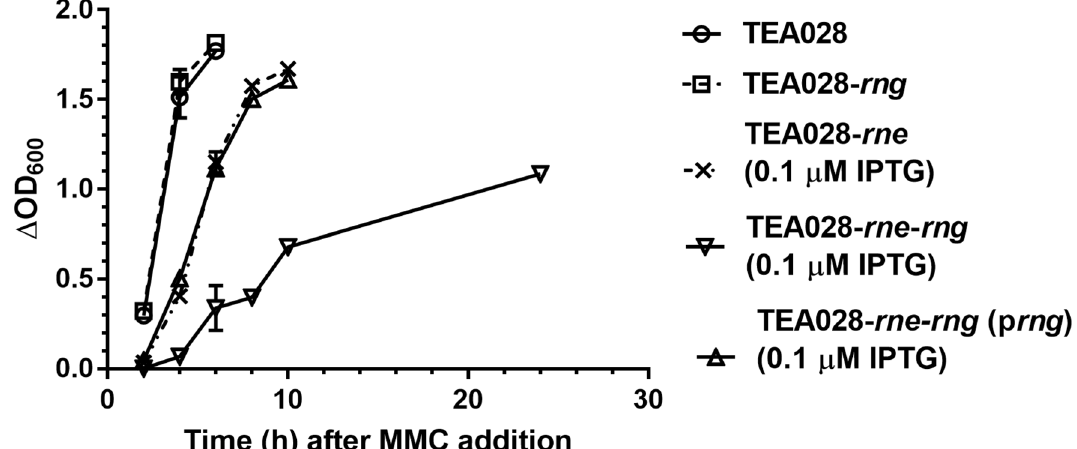
Figure 1. Growth of EHEC TEA028 and its RNases E and G derivative strains in cultures treated or non- treated with mitomycin C (MMC). Cultures of TEA028 (parental strain) and its RNases E and G derivatives were grown in Luria Bertani medium to optical density at 600 nm (OD 600 ) of 0.30–0.35 at which point the cultures were split and an aliquot was treated with MMC (1 µg/mL) to induce the stx2 -phage lytic cycle. Thereafter, samples were collected at various time points to measure OD 600 . The strains TEA028- rne and TEA028- rne -Δ rng underproduce RNase E when the medium is supplemented with low levels of isopropyl β-d-1-thiogalactopyranoside (IPTG), as indicated. For each time point, the OD 600 of MMC-treated cultures was subtracted from the